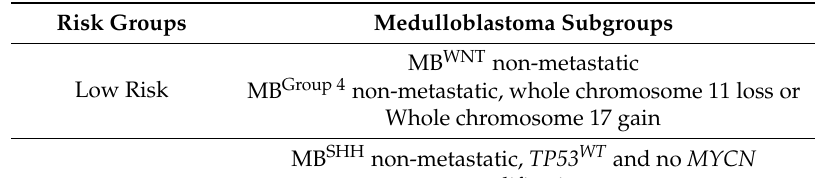
Table 5. Patient risk stratification based on molecular and clinical